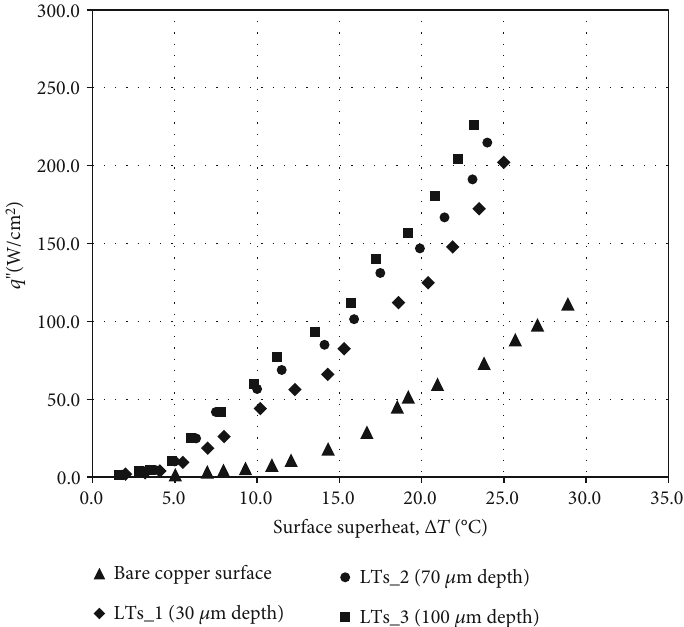
Figure 5: Heat fl ux variation with superheated surface for plain copper surface and laser-textured